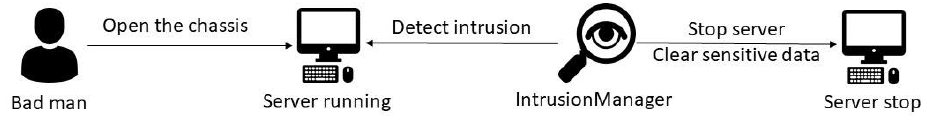
Figure 22. Diagram of the test case 1 process.